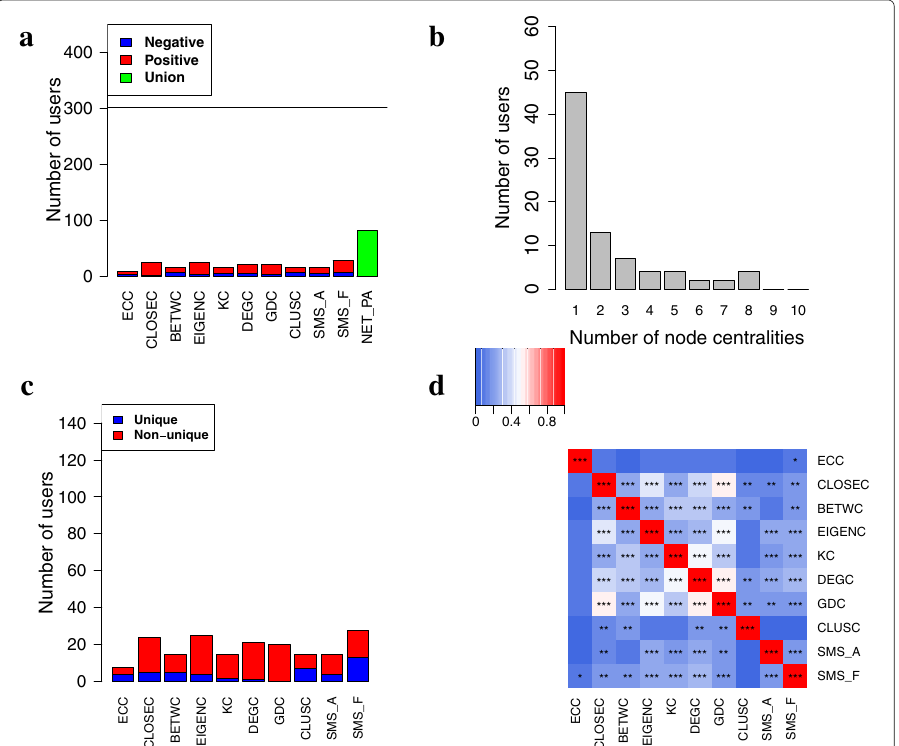
Fig. 8 Results regarding users whose network centralities co-evolve with physical activities. a The number of users with co-evolution relationship for each of the 10 centralities individually (ECC to SMS_F) or by at least one of them (NET_PA). Red and blue portions of the given bar indicate users whose centralities are positively and negatively correlated with physical activities, respectively. b The number of users found by exactly k centralities ( k = 1,2, ... ,10). c The number of users that are unique to the given centrality, i.e., for a given user, only for this centrality, the user’s centrality values are significantly correlated with physical activities. d Pairwise overlaps between users with co-evolution relationship predicted by the different centralities. An overlap is measured as Jaccard index, and the resulting overlap size is indicated by the given color. The significance of the overlaps is computed by using the hypergeometric test. *, **, and *** indicate